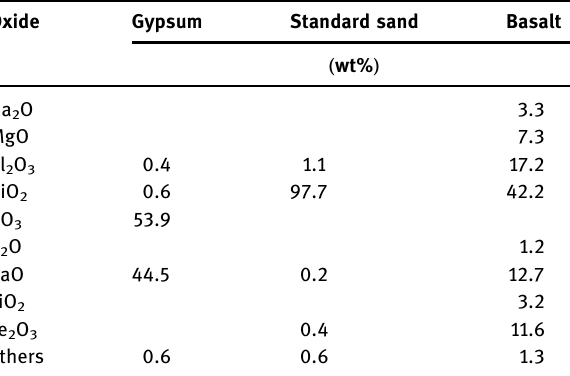
Table 2: Chemical composition of gypsum, silica sand and basalt Oxide Gypsum